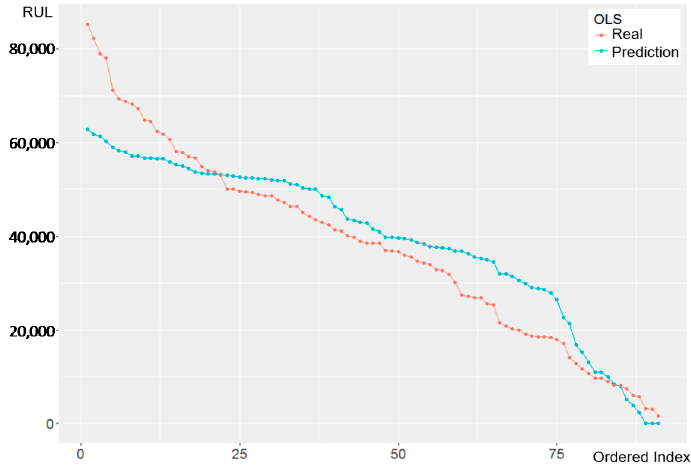
Figure 8. Fitted plot of OLS.